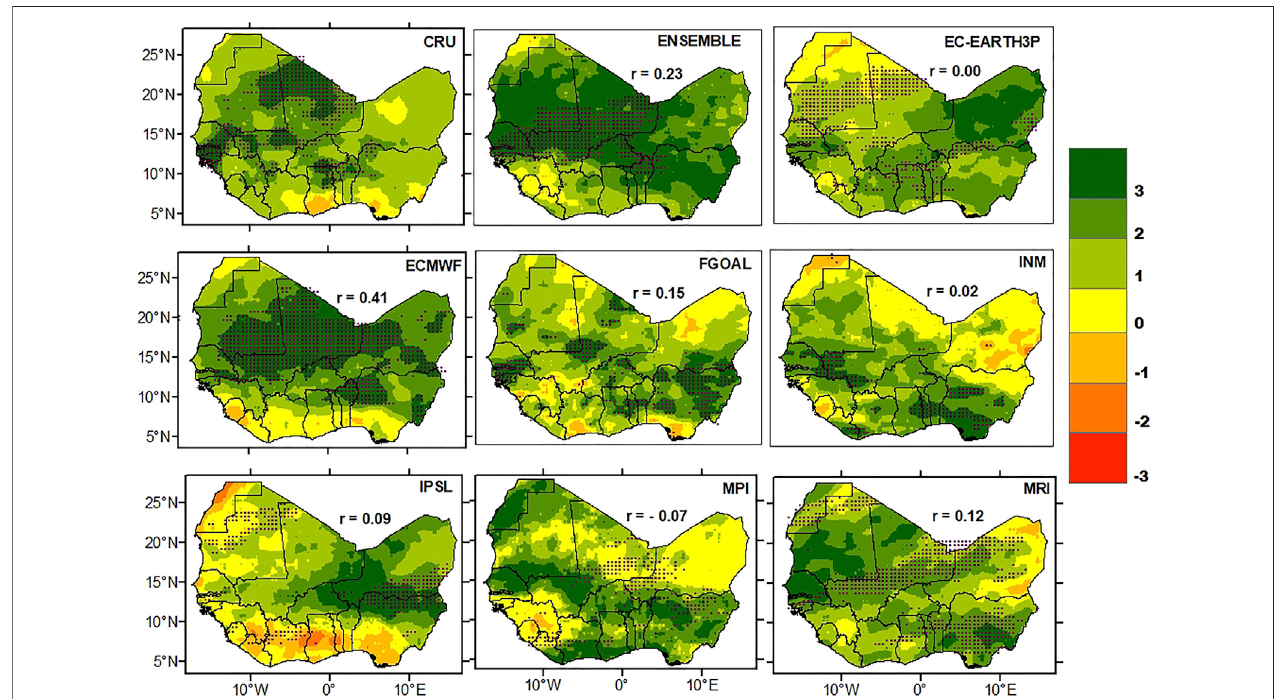
FIGURE 8 | Observed and simulated distribution of Z-statistics for SPEI-1 over West Africa during 1985 – 2014. The positive and negative values indicate the grid withincreasingand decreasing trends,respectively.Thegridswithsigni fi canttrends atthe0.05 con fi dencelevelarehatched.r indicates thePearsonpatterncorrelation between CRU and each HighResMIP simulation.